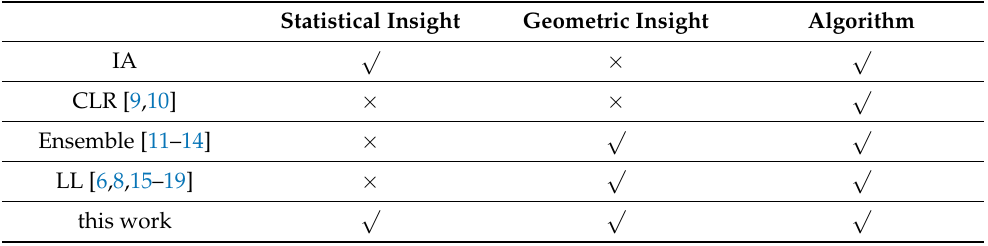
Table 1. A summary of advantages and disadvantages of related works on IA (iterates averaging), CLR (cyclical learning rates), ensemble, and LL (loss landscape), and this work. We reviewed whether they provided statistical or geometric insights and practical algorithms. Statistical Insight Geometric Insight